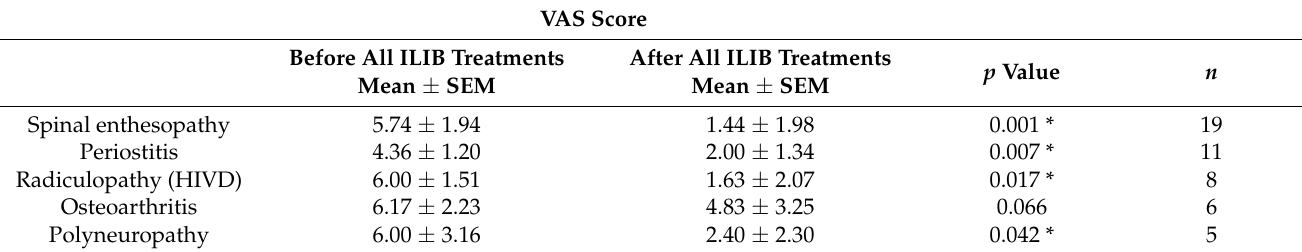
Table 3. The pain intensity change of different disease